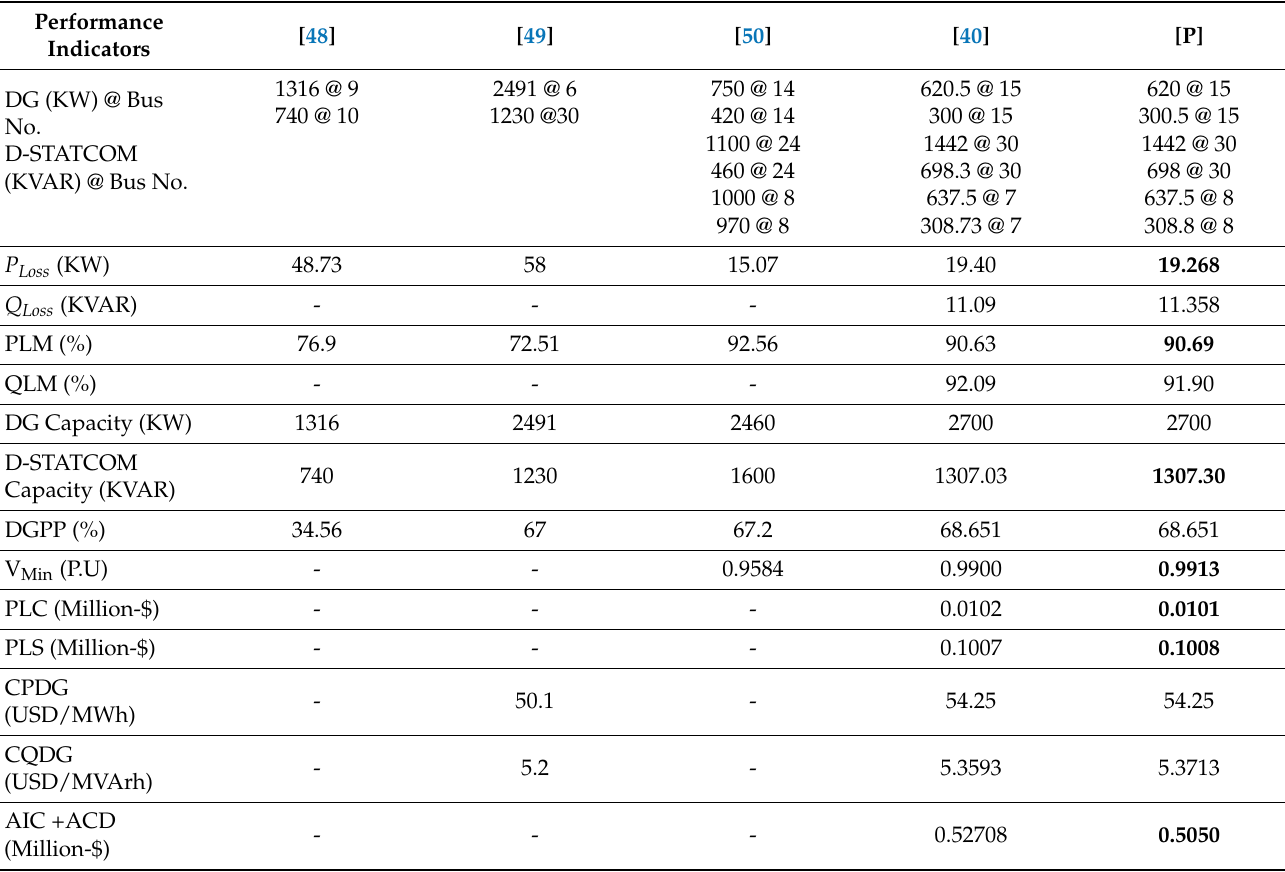
Table 30. Comparisons of results with C2/S1 under NL for the 33-bus MDN (REG + D-STATCOM@LPF = 0.9). Performance